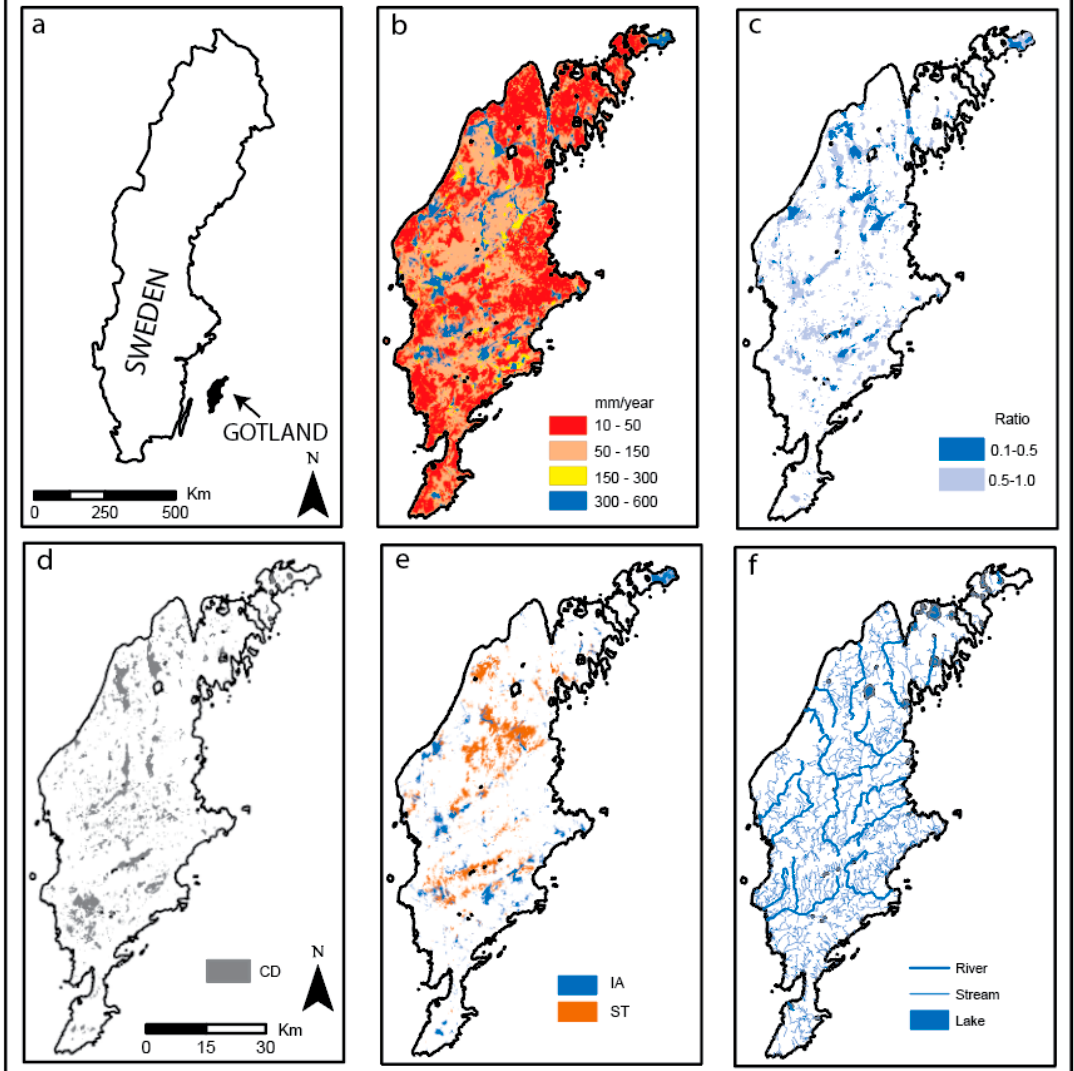
Figure 1. GIS maps and results from GIS analysis to identify areas with potential for MAR. ( a ) Map of Sweden and location of Island of Gotland. ( b ) Groundwater storage capacity (mm/year) [25]; ( c ) Ratio of groundwater recharge/storage capacity; only values below 1.0 are shown (GS); ( d ) Closed depressions (>1 ha) in the bedrock with no contact with the Baltic Sea (CD); ( e ) Areas from the lithological 3D model, blue: areas >4 m sand and/or gravel (IA) suitable for infiltration, red areas >4 m till and/or clay (ST) suitable for construction of surface storage dams; ( f ) Surface waters, i.e., raw water source (S).